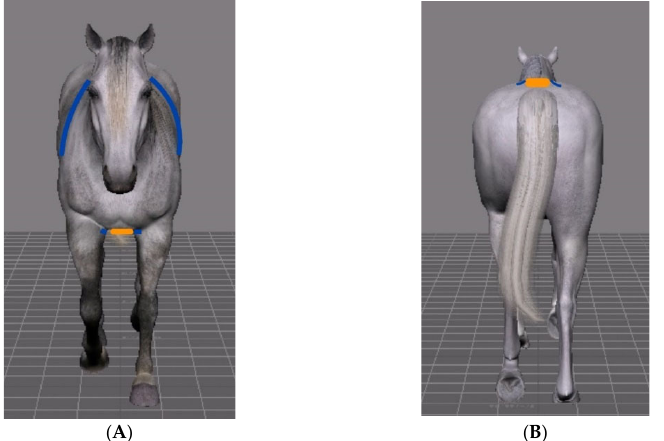
Figure 1. Representation of the position of the accelerometer (orange). ( A ): fixed in pectoral (PECT) position with a girth. ( B ): attached to the skin over the midline of the sacrum (SML).